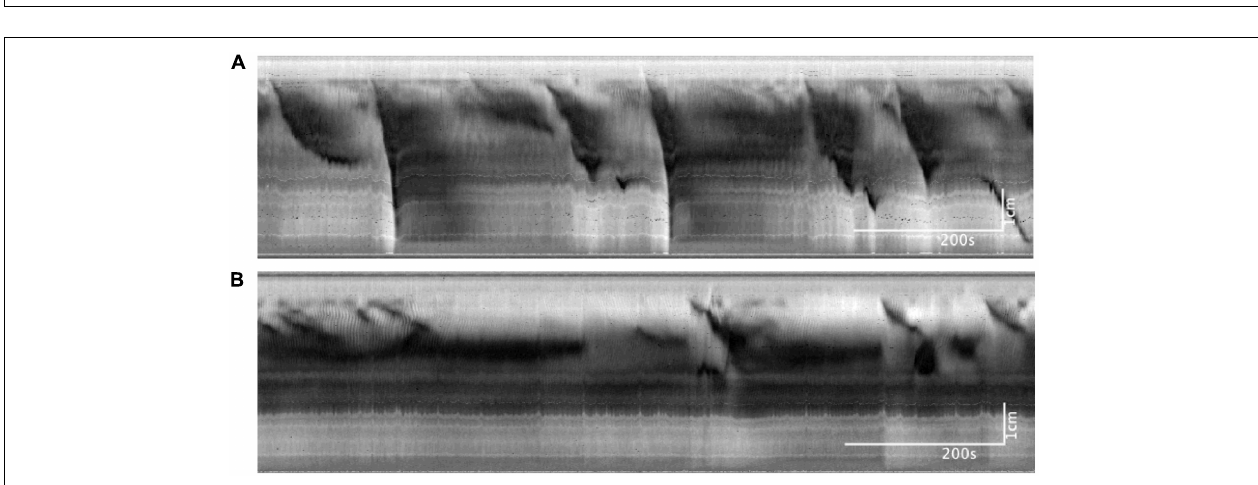
FIGURE 6 | The effect of sudden distention on colonic motor activity caused by a blockage in outflow. When this occurred, LDCs immediately developed to expel the blockage and restore baseline activity levels. (A) Spatiotemporal map. (B) Average colonic diameter over time.